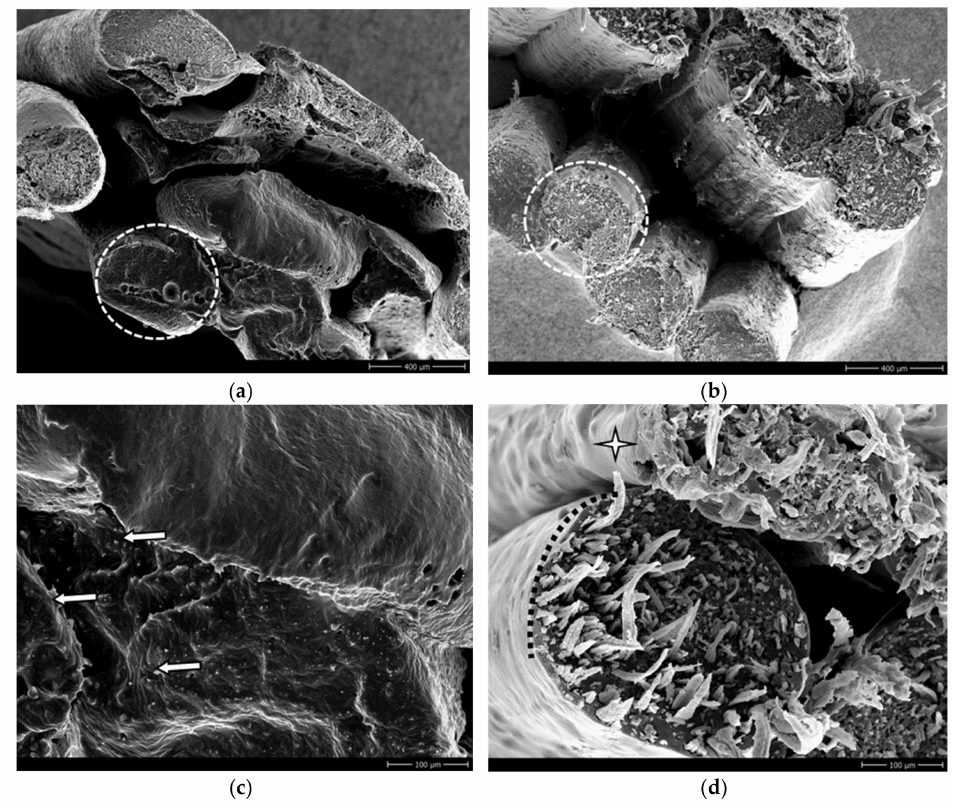
Figure 8. Scanning electron microscopy (SEM) images. Image ( a ) shows the printed structure of the ESD-ABS test specimen and ( b ) shows ESD-PLA with 200x magnification, where the printed columns are marked with a discursive circle. On image ( c ), the arrows indicate the carbon particles in the ESD-ABS, and in ( d ), the white star shows the side of a column in printed ESD-PLA and the dashed black curve indicates the margin of it. The images were taken with 1700x